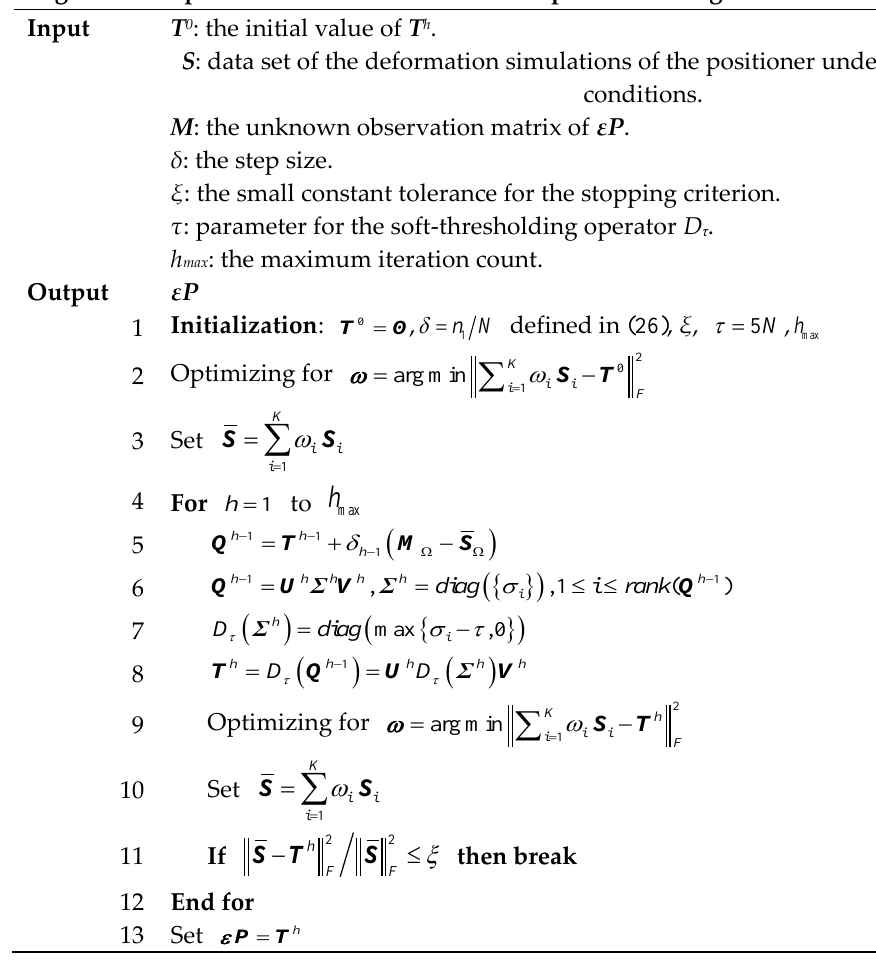
Figure 4. Pseudo-code for the optimization process.